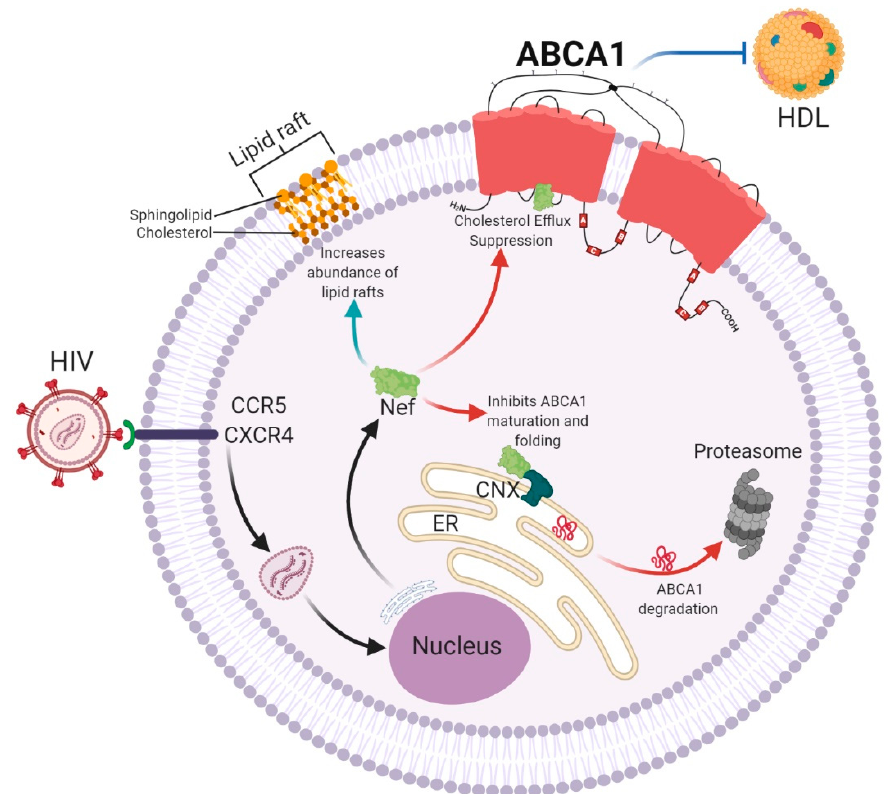
Figure 2. Effects of the viral negative factor (Nef) protein in human immunodeficiency virus (HIV)-infected cells. HIV enters cells by binding to the chemokine receptor 5 (CCR5) and chemokine receptor type 4 (CXCR4) and uses the host cell machinery to synthesize viral proteins such as Nef. Nef increases cholesterol biosynthesis and induces lipid raft formation, required to produce new virions. Nef also inhibits cholesterol efflux by suppressing ABCA1 activity, inducing structural and functional modifications of high-density lipoproteins (HDL). In addition, Nef blocks the interaction of the endoplasmic reticulum (ER) chaperon calnexin (CNX) with ABCA1, altering its folding and maturation. Nonfunctional and misfolded ABCA1 is retained in the ER and degraded in the proteasome, resulting in further accumulation of intracellular cholesterol, creating a favorable microenvironment for viral replication and release.